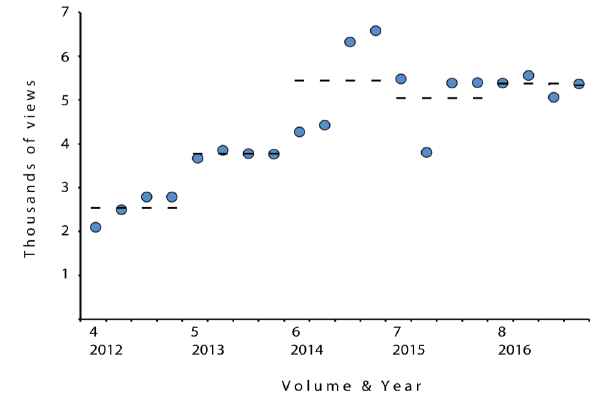
Figure 1. Numbers of views (in thousands) of Frontiers arti- cles during the 3-month period following publication of each issue, since moving to eScholarship in March 2012. Horizontal dashed lines indicate the mean for each volume.